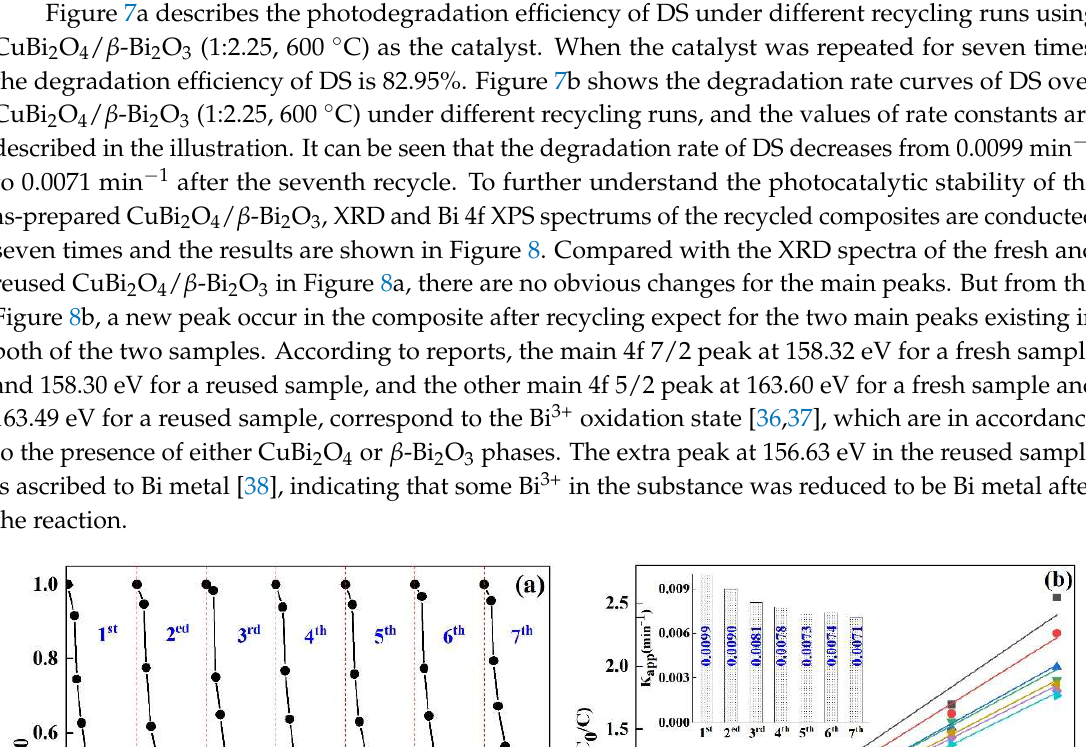
Figure 7. ( a ) Photodegradation efficiency of DS; ( b ) plots of ln(C 0 /C) versus irradiation time ◦ C) under different recycling runs. The illustration in ( b ) shows the over CuBi 2 O 4 / β -Bi 2 O 3 (1:2.25, 600 °C) under different recycling runs. The illustration in ( b ) CuBi 2 O 4 / β -Bi 2 O 3 (1:2.25, 600 degradation rate constants of DS under different recycling